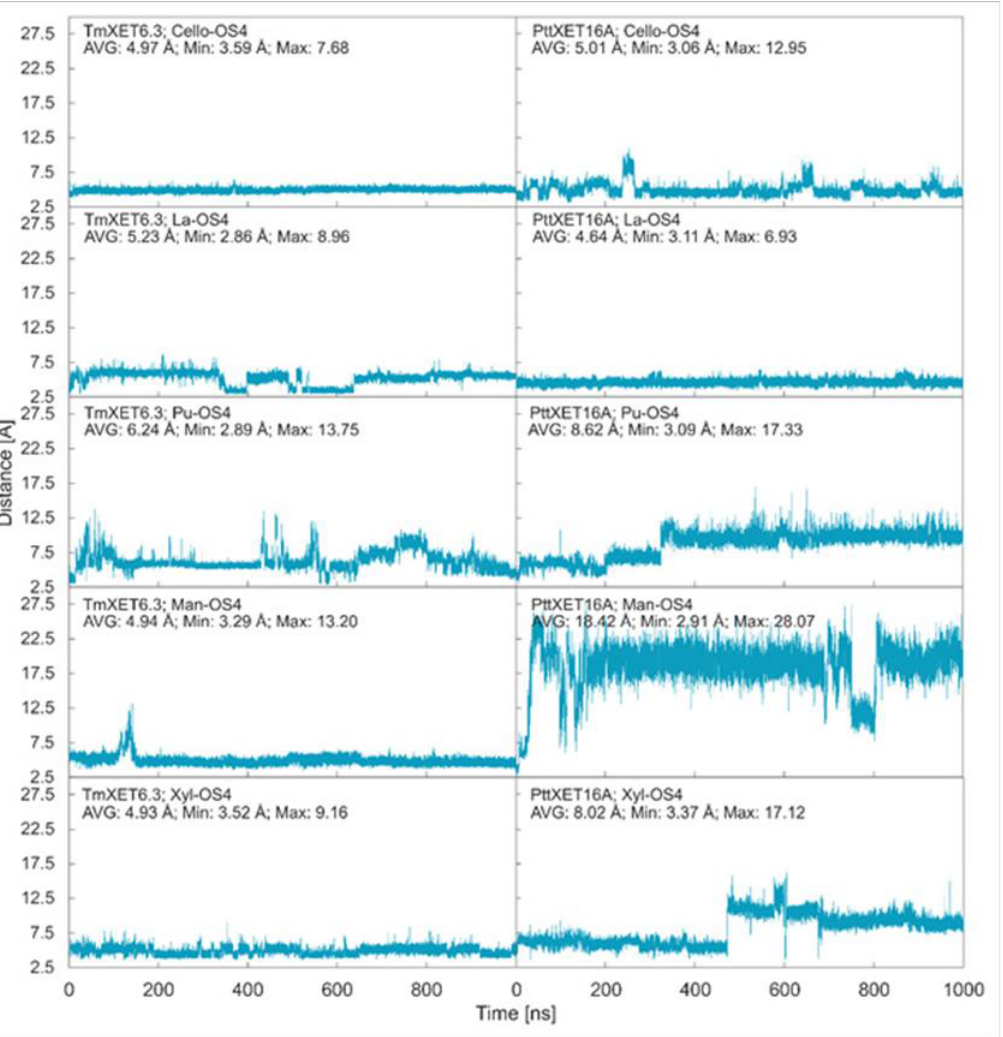
Figure 3. Time dependence of the distance (Å) between the C1 atom of the XG-OS7 donor and the O4 atoms of acceptors during MD simulations with TmXET6.3 and PttXET16-34A. The C1 and O4 atoms form a glycosidic bond.